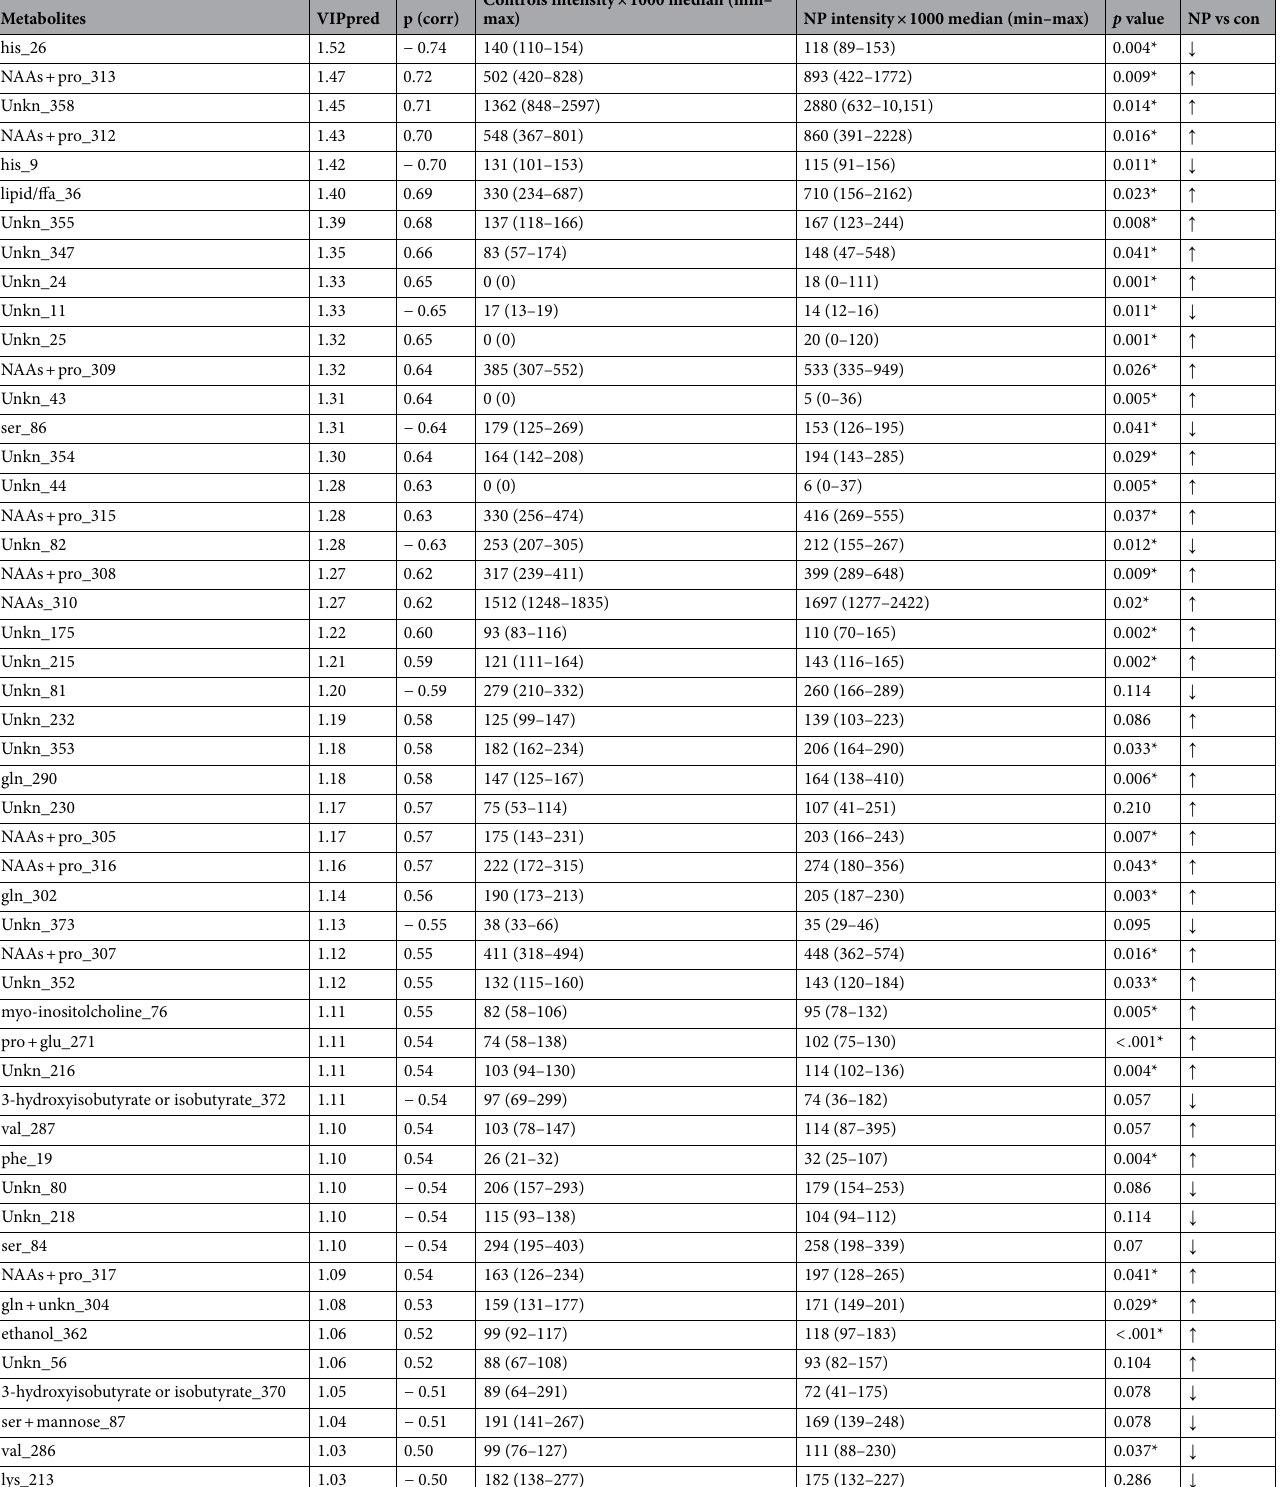
Table 3. Metabolites in plasma significantly differentiating between chronic neuropathic pain (NP) patients and healthy controls according to OPLS-DA. The metabolites are listed in descending order for VIPpred. A negative p (corr) indicates lower levels in patients while a positive p(corr) indicates the opposite. The p-value is according to Mann–Whitney test and *Refers to statistically significant differences between controls and NP patients. Up or down regulation is reported in the column furthest to the right. His histidine, NAAs N-acetyl aspartate, Pro proline, Ser serine, Ffa free fatty acid, Unkn unknown, Lys lysine, Gln glutamate, val valine, phe